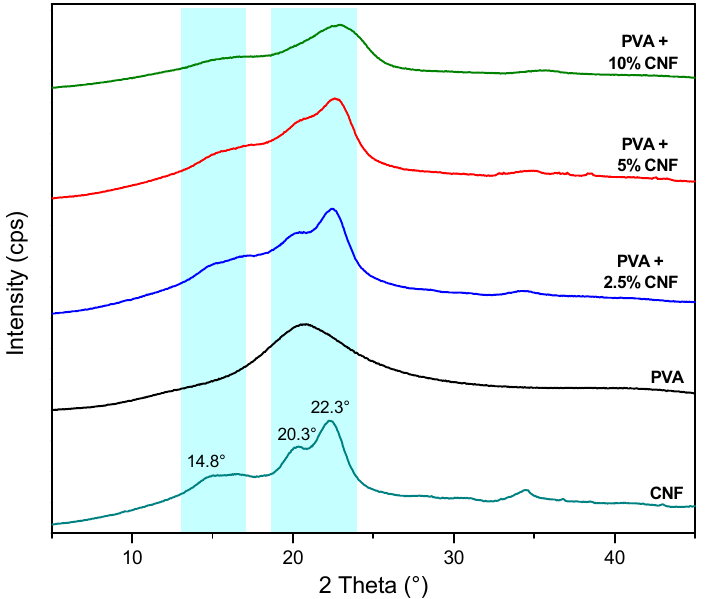
Figure 2. XRD of prepared poly(vinyl alcohol) (PVA)/cellulose nanofibril (CNF) sponges, compared with neat PVA and CNF.